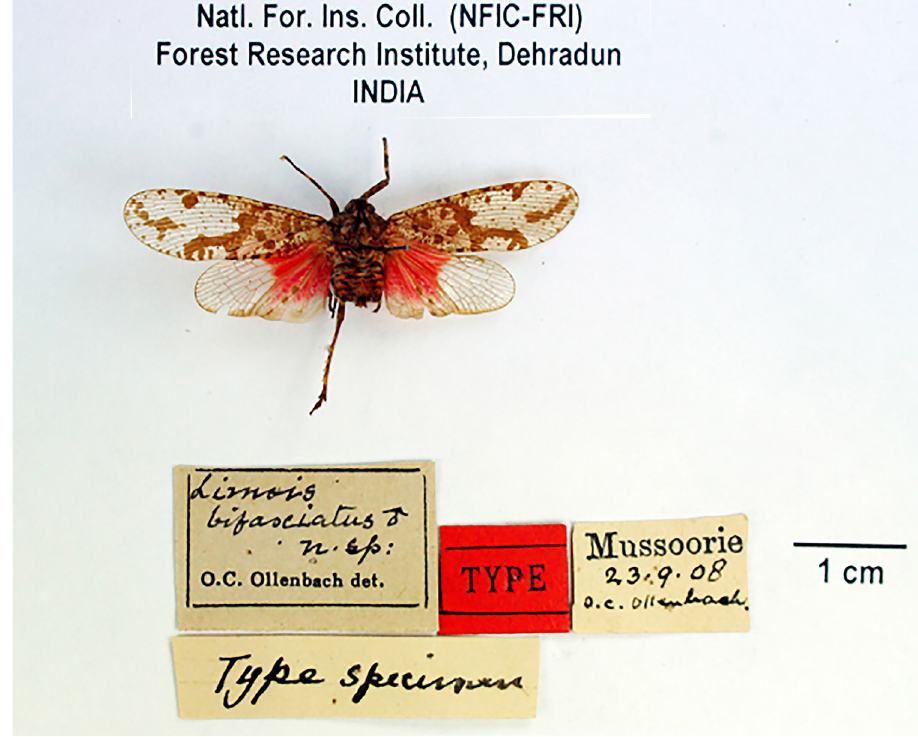
Fig. 13. Limois bifasciatus Ollenbach, 1928, holotype, adult